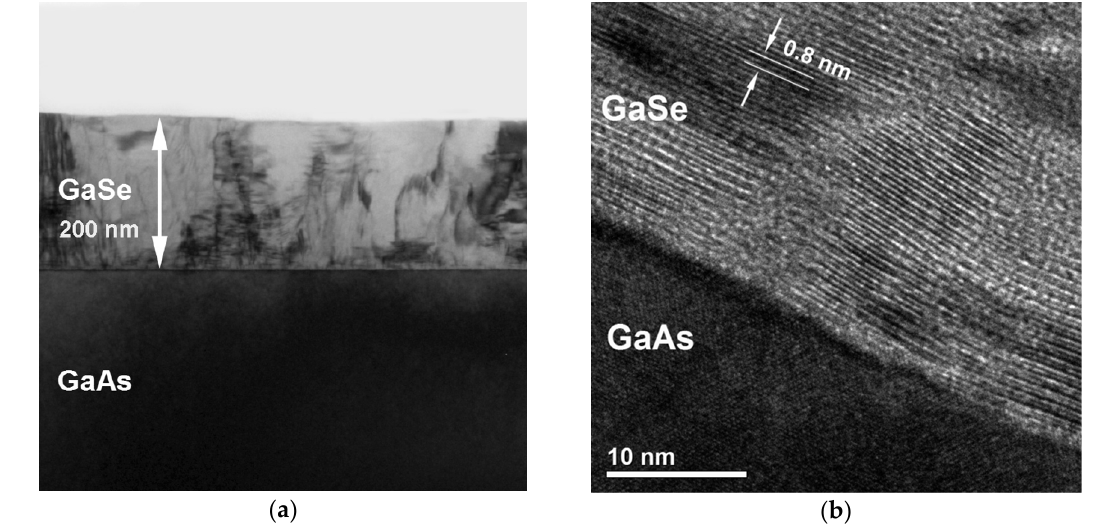
Figure 3. ( a ) Cross-section TEM image of the GaSe layer grown on the GaAs(001) substrate at T S ~ 400 °C (Se/Ga(BEP) ~ 34) (sample # GS1 ); ( b ) high-resolution TEM (HRTEM) image of the GaSe/GaAs(001) heterointerface for the same layer.